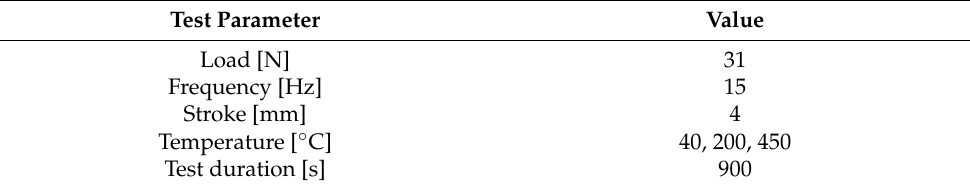
Table 6. SRV testing parameters. Test